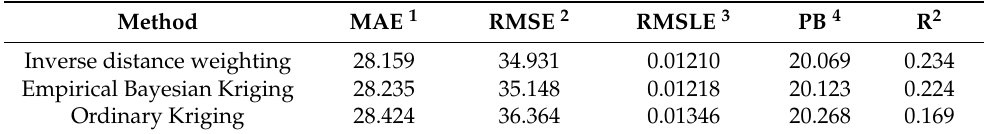
Table 4. Summary of the cross-validation